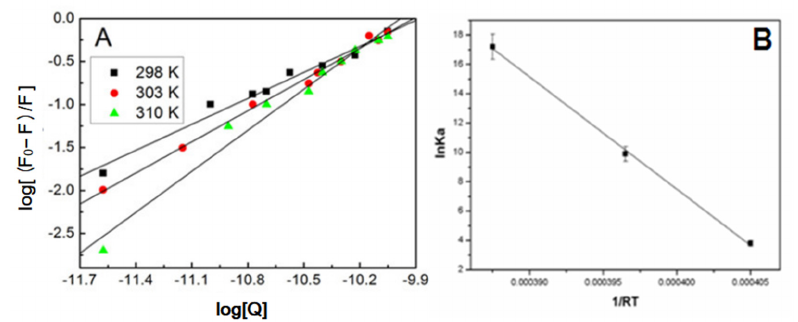
Table 1. Ster–Volmer quenching constants of AgNPs and HSA at varying temperatures. T (K)